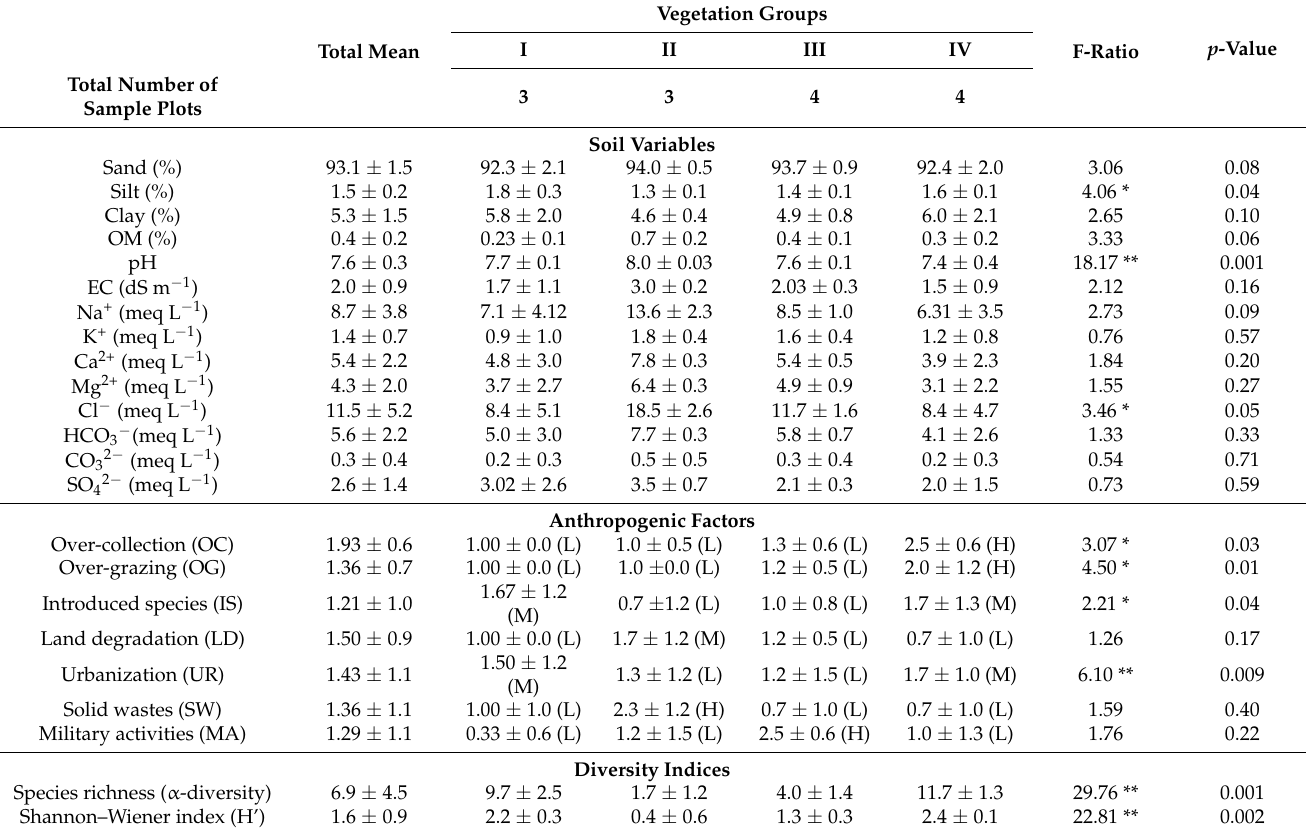
Table 3. Mean values, standard deviations ( ± SD) and ANOVA F-values of the soil variables, anthropogenic factors, and diversity indices in the sample plots representing the four vegetation groups obtained by cluster analysis of the Cairo-Suez road unprotected area (SR). Abbreviations of soil factors: OM = organic matter, pH = soil reaction, EC = electrical conductivity. Significant differences: * p ≤ 0.05, ** p ≤ 0.01. Categories of anthropogenic activities: H = high, M = moderate, L =